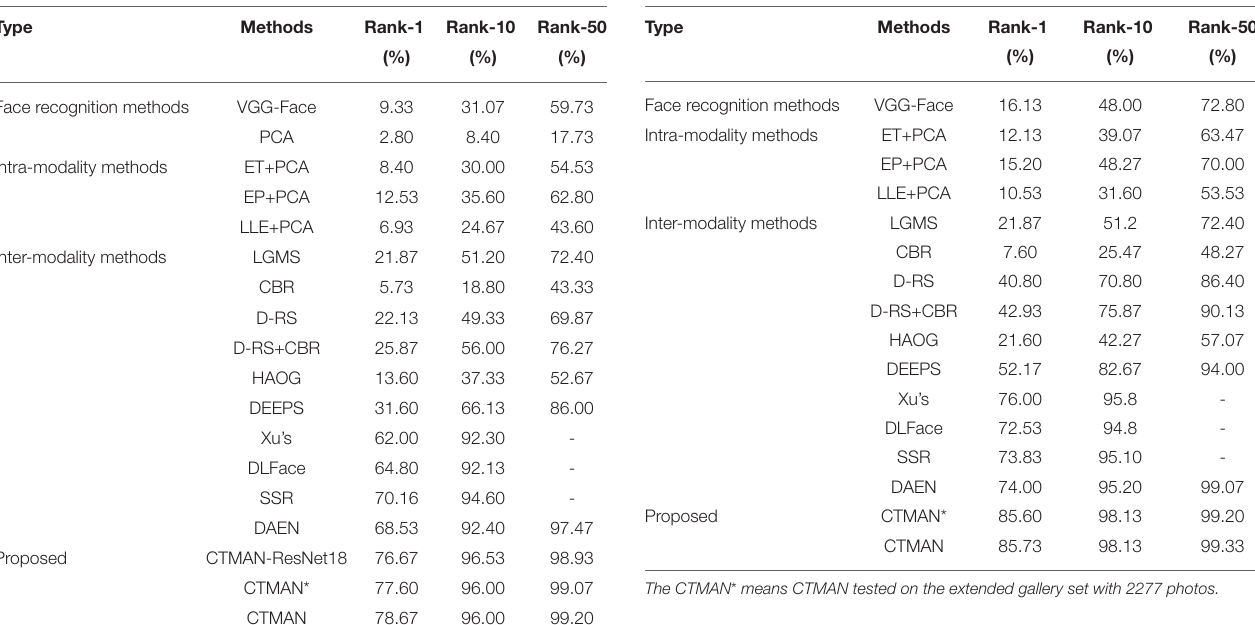
TABLE 5 | Comparison experiment results on the S1 setup. TABLE 6 | Comparison experiment results on the S2